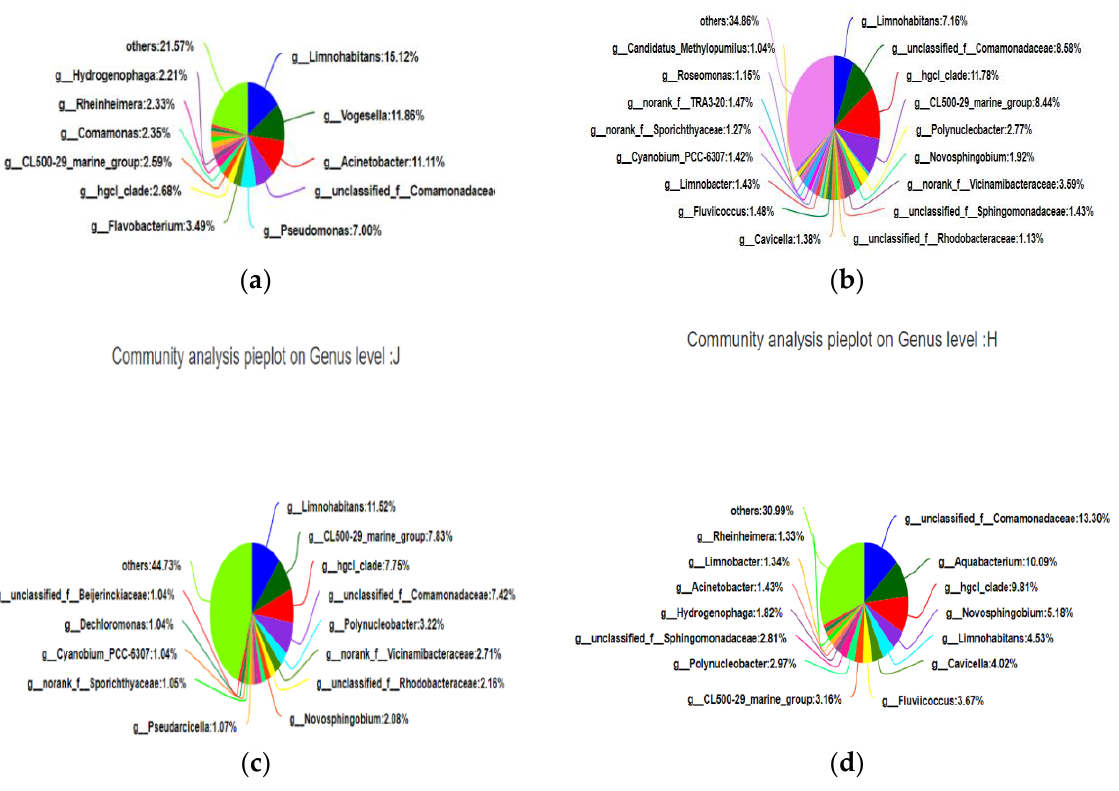
Figure 6. ( a ) Community composition analysis map of the Beibei District, ( b ) community composition analysis of the Shapingba District, ( c ) community composition analysis of the Jiangbei District, and ( d ) community composition analysis of the Hechuan District.